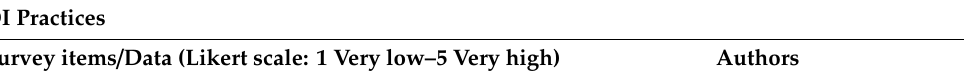
Table 2. Open innovation (OI) Practices survey questions.